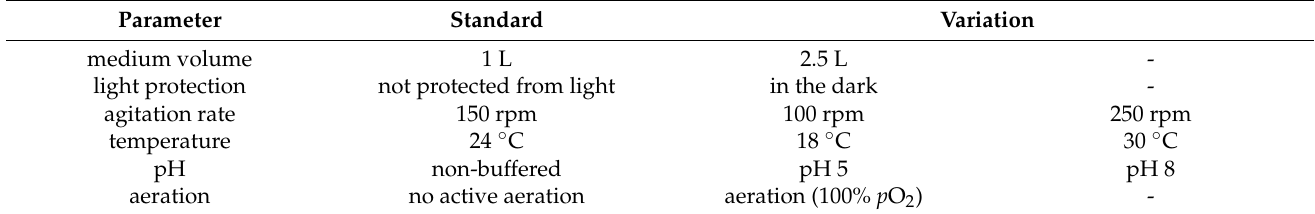
Table 4. Fermentation parameters tested in a lab-scale